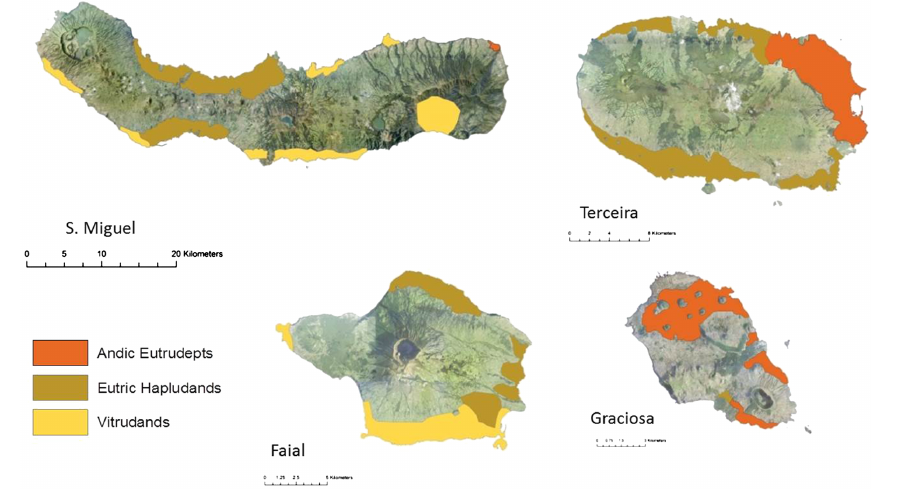
Figure 3. Major soil categories represented in potential new areas for viticulture in S. Miguel, Terceira, Faial and Graciosa islands of the